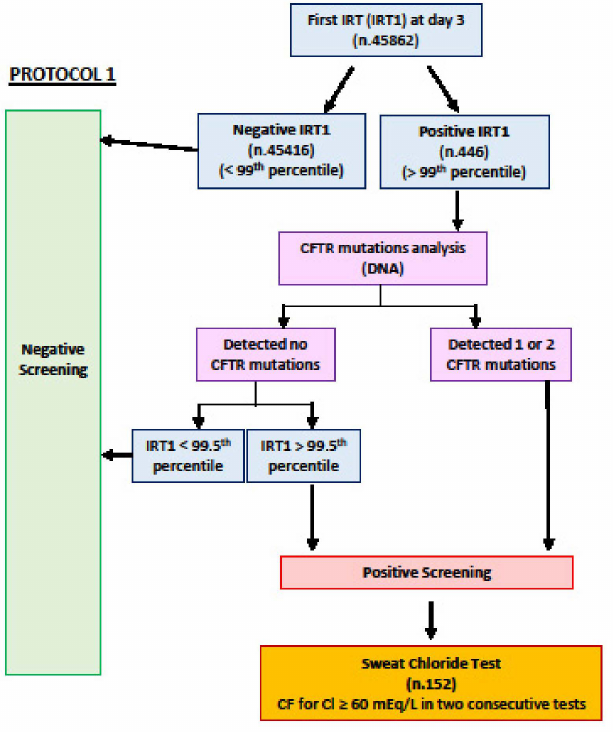
Figure 1. Protocol 1 IRT/DNA.